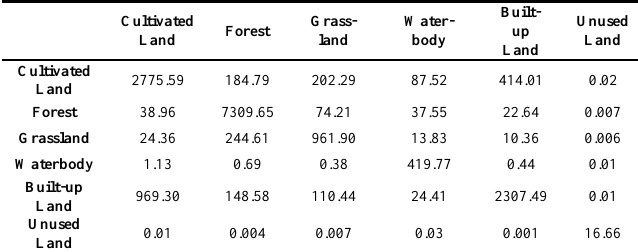
Table 6. Conversion of Land Types from 2020 to 2035 LC scenario (km 2